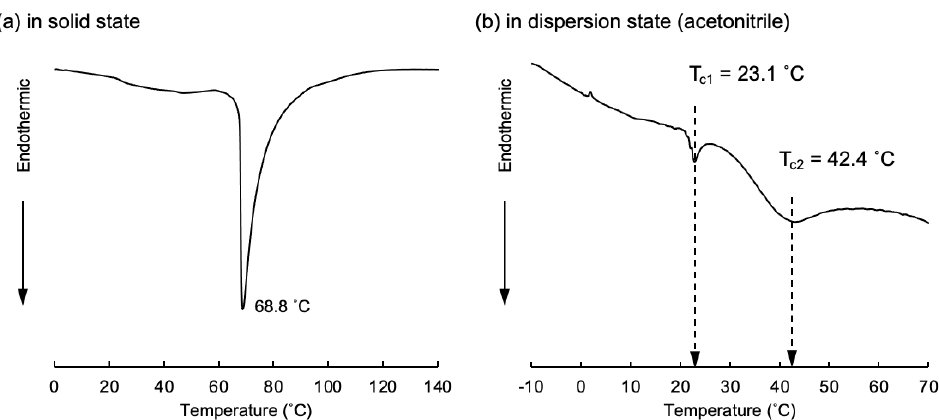
Figure 3. DSC thermograms of Sil − VP G 15 ( a ) in the solid state and ( b ) in the suspension state (acetonitrile). Heating rate: 2 ◦ C min − 1 for the solid state and 1 ◦ C min − 1 for the suspension state.